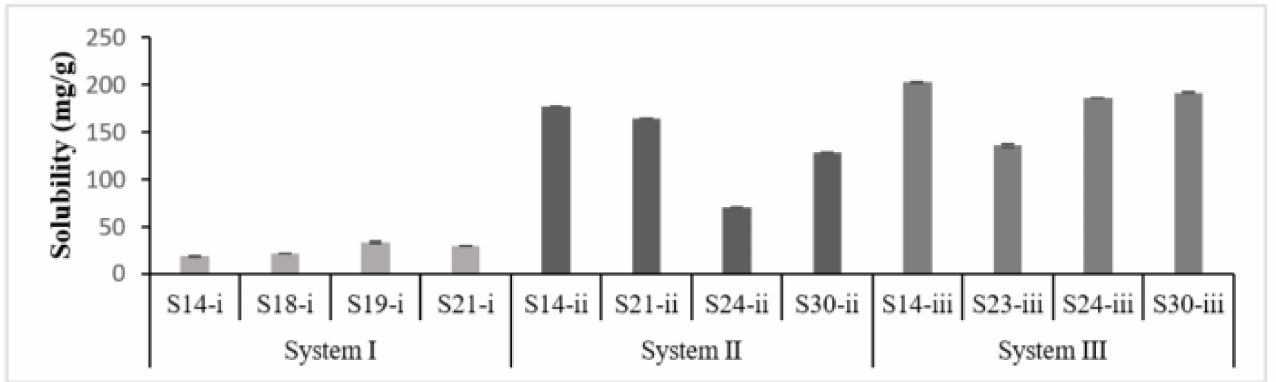
Figure 2. Graphical representation of PGZ equilibrium solubility in selected SNEDDS formulations. S-i, S-ii and S-iii are formulations related to systems I, II and III,